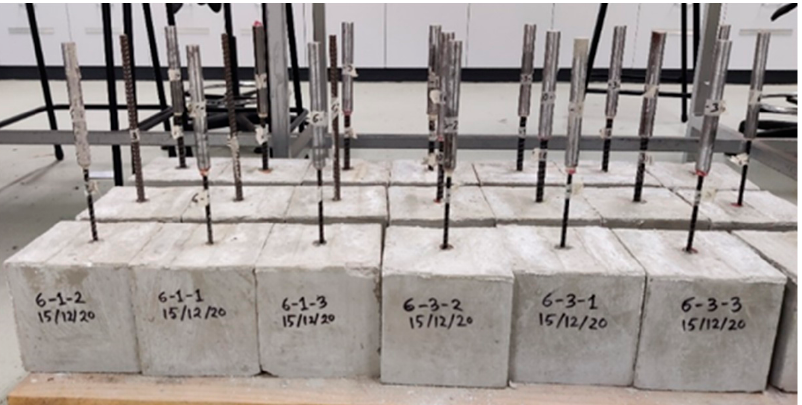
Figure 6 . Pull-out specimens after 28 days of curing.